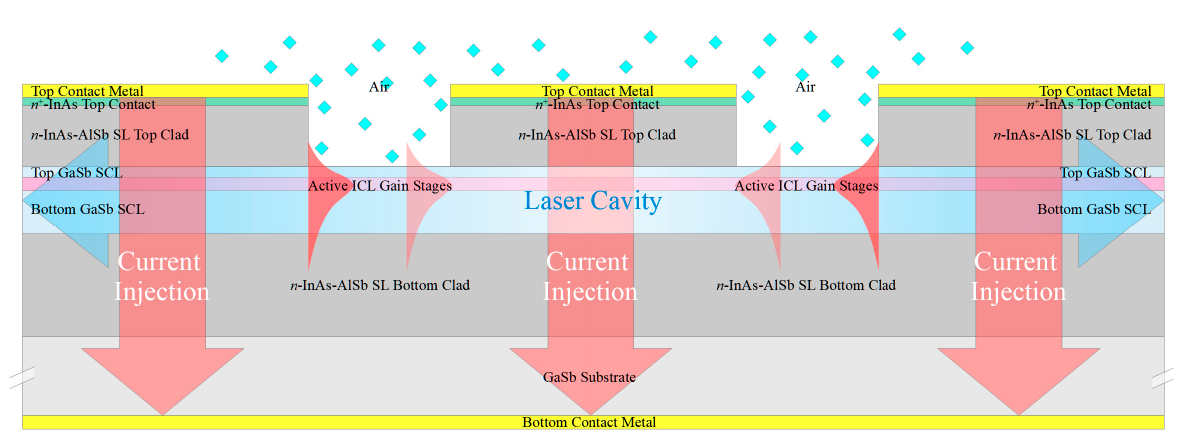
Figure 6. Schematic side view of an active gain waveguide in which notches are etched to allow overlap of the propagating optical mode with ambient.